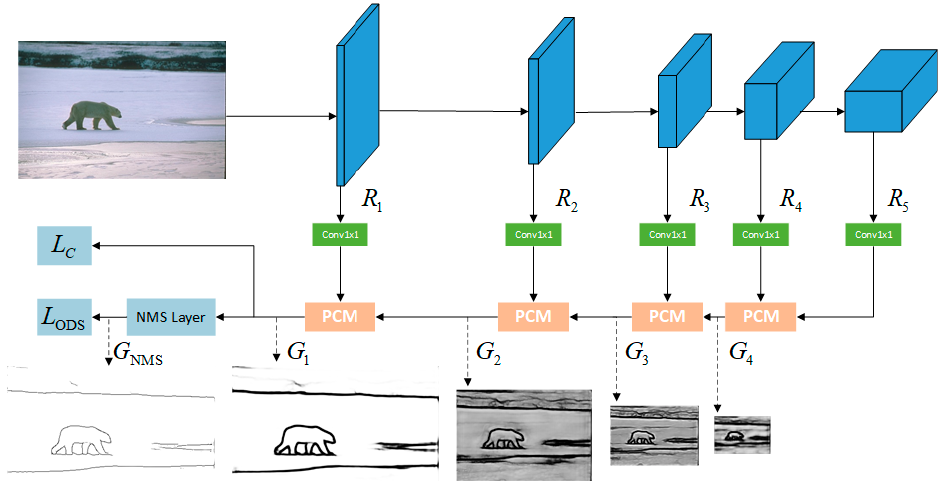
Figure 2. Adaptive feature pyramid network architecture.